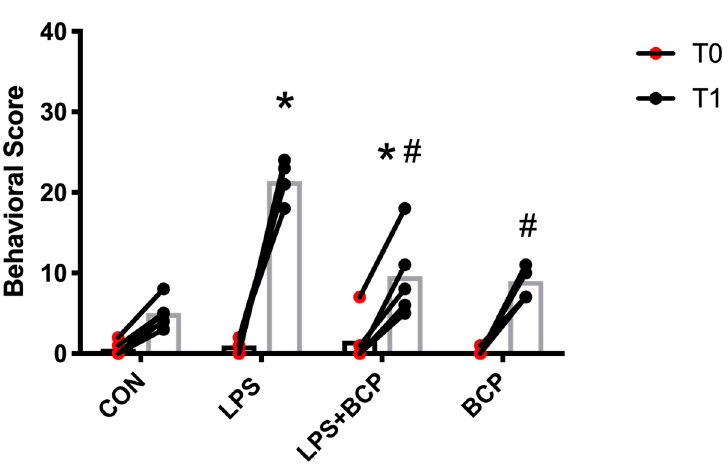
Figure 10. Composite score of behavioral results of female BALB/c mice before cystitis induction (T0)